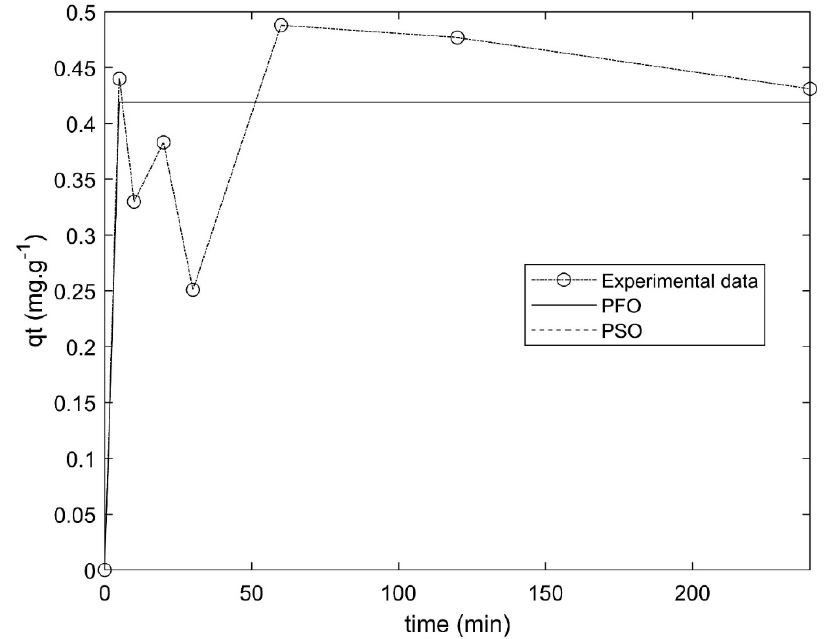
Figure 7. Phosphate adsorption isotherms of Mg-biochar derived from pyrolysis of hardwood. Table 4. Langmuir and Freundlich isotherms parameters for the PO 4 adsorption using Mg-bio- char.